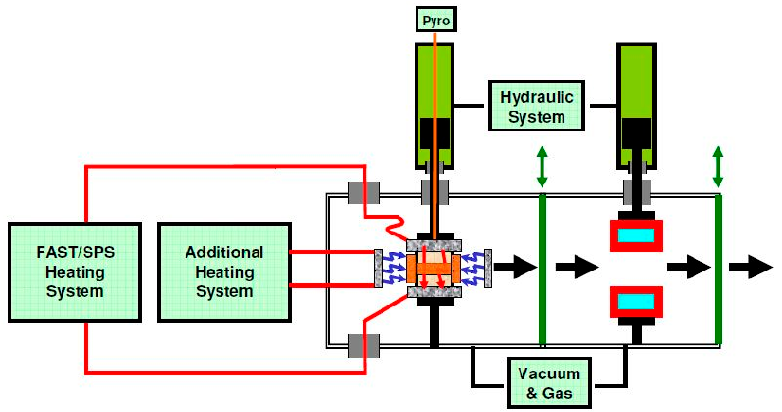
Figure 9. Schematic illustrating the concept of an industrial high throughput sintering system. Open re-prints from reference